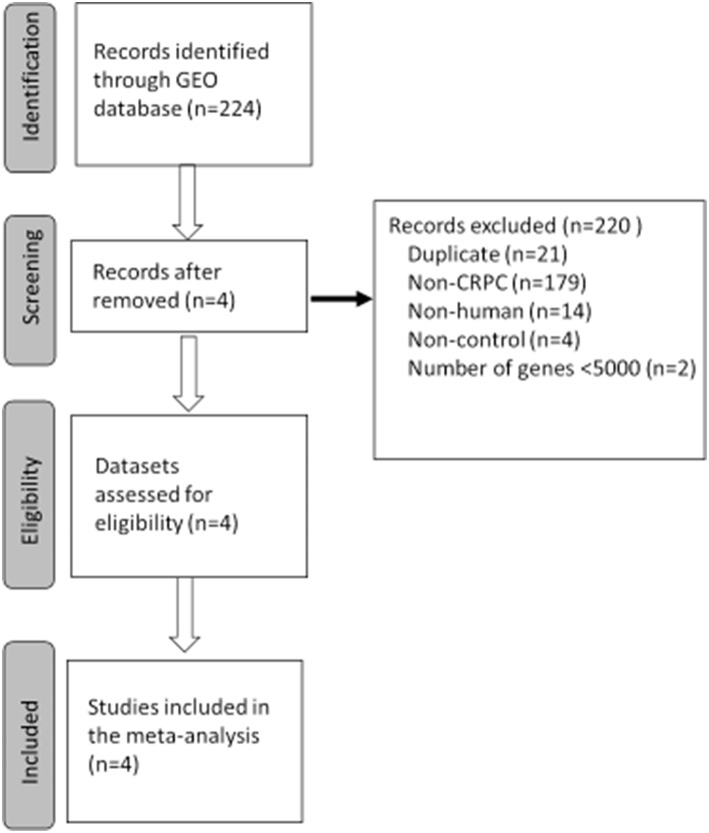
Flowchart of the selected process to select gene expression datasets for meta-analysis of castration resistant prostate cancer (CRPC). GEO, Gene Expression Omnibus.